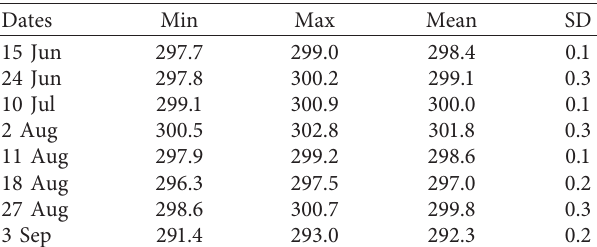
Figure 7: Comparison of the observation and the estimation for different land covers: (a) T Table 7: Minimum (min), maximum (max), mean, and standard deviations (SD) of grids T a K interpolated via the IDW method with a 90m × 90m resolution of the study area over eight dates.